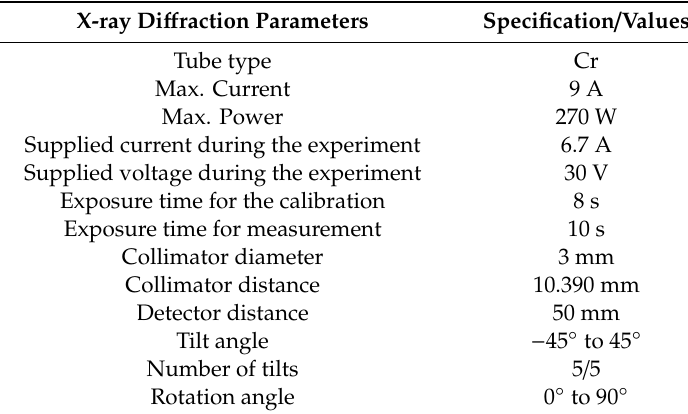
Table 4. XRD measurement parameters.